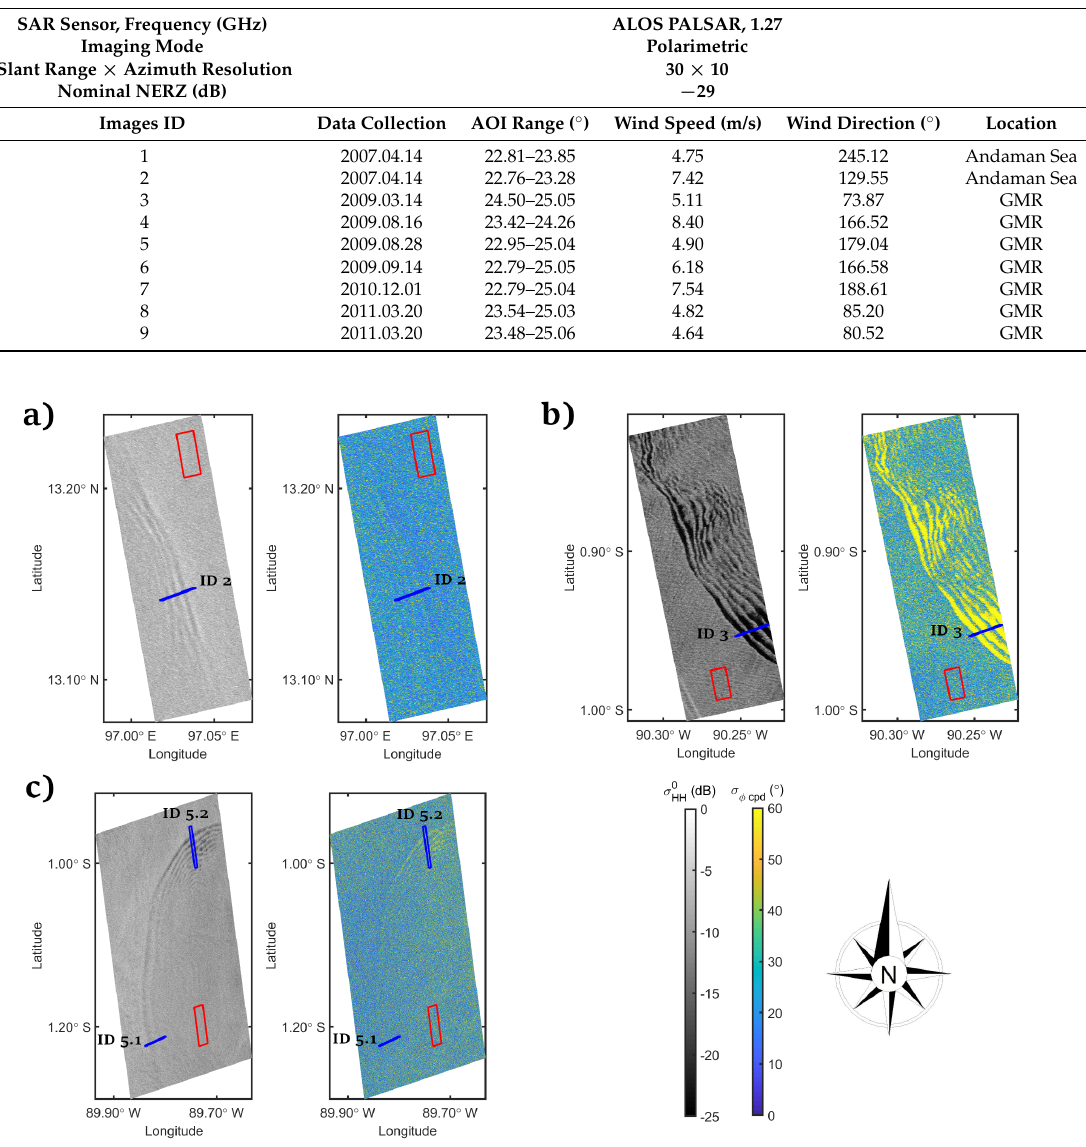
Table 1. General information on synthetic aperture radar (SAR) imagery and overview of the data set. SAR Sensor, Frequency (GHz)